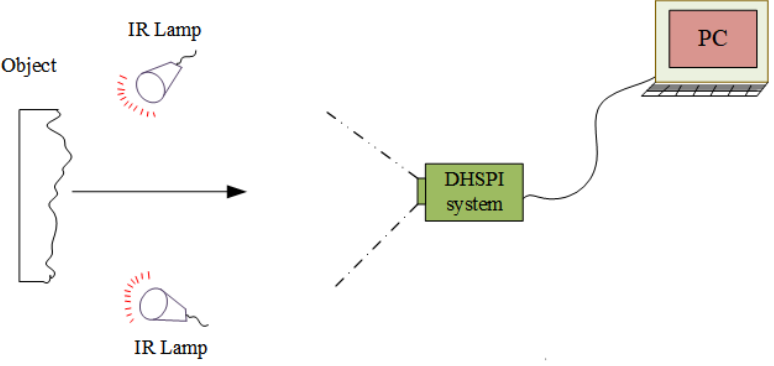
Figure 7. Schematic diagram of the measuring device.